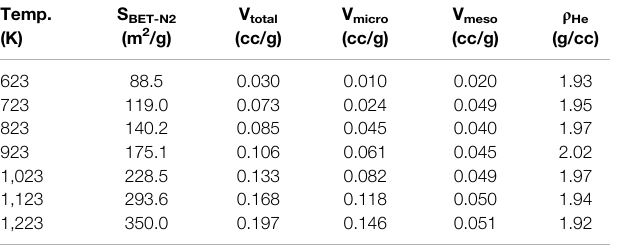
TABLE 4 | Effect of holding time and heating rate on the textural characteristics of chars from